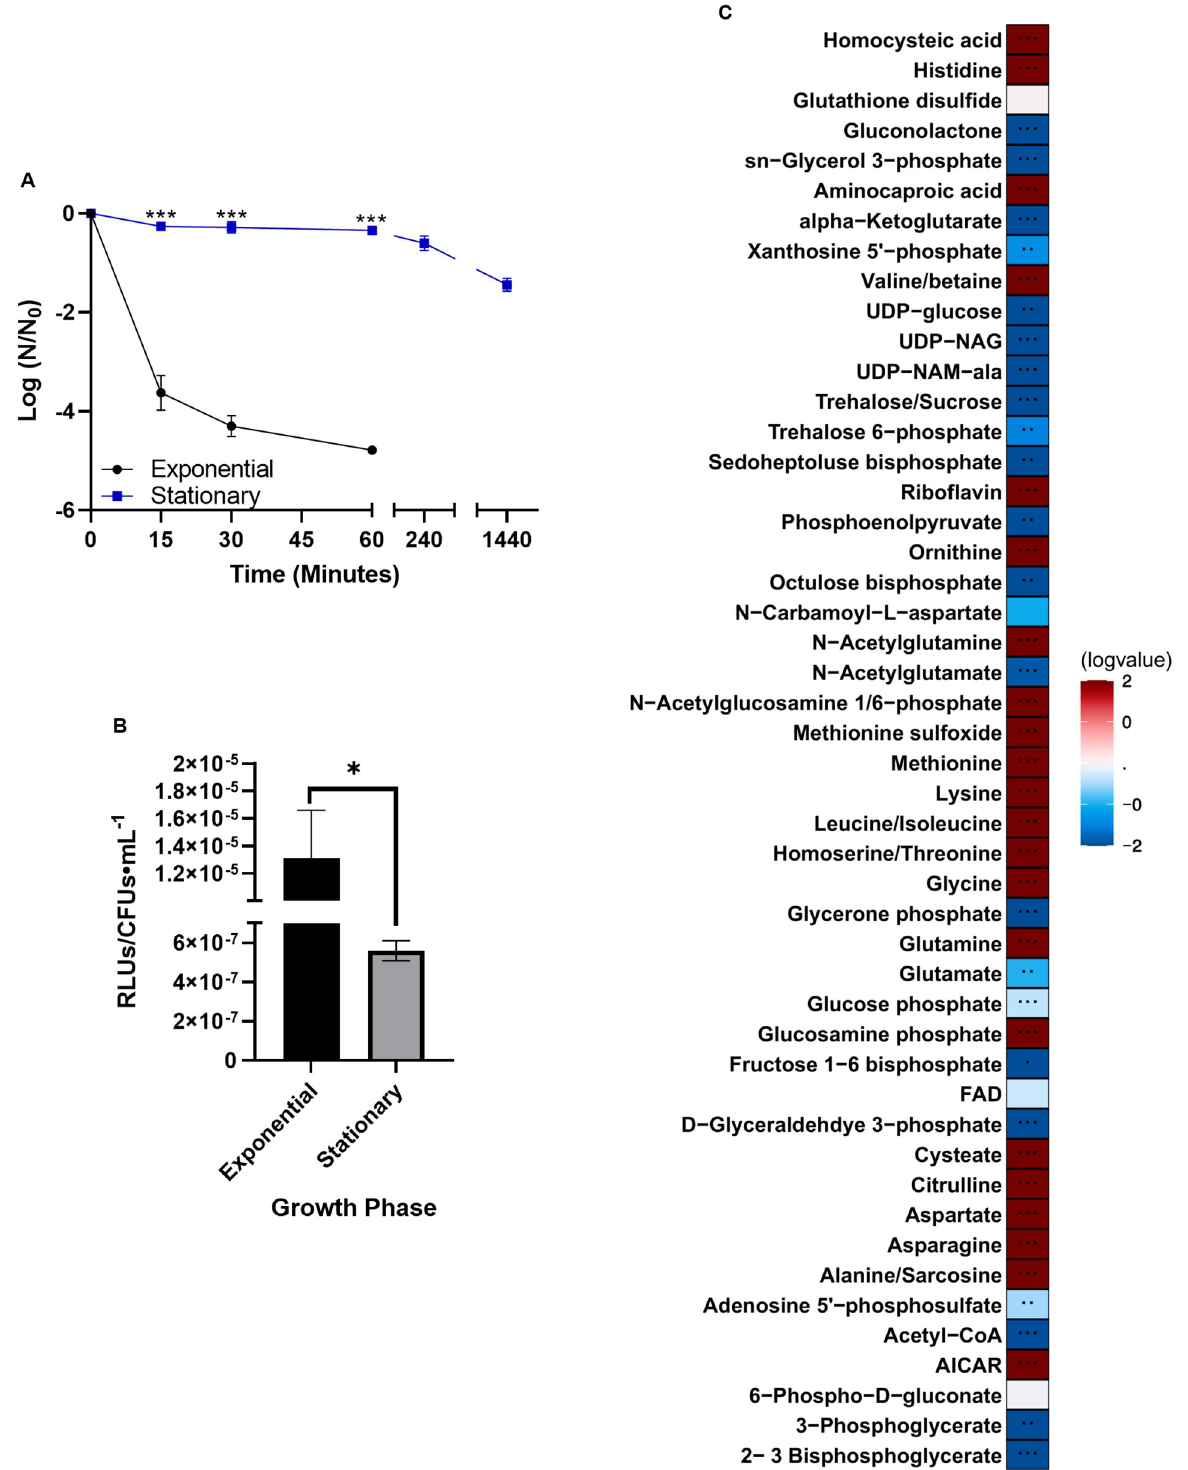
Fig 1. Cells in stationary phase show increased daptomycin tolerance and an altered metabolic profile. (A) Cells were treated with 30 μ g/mL daptomycin as described in Materials and Methods. Shown are the average log ratios of colony forming units ± standard deviations for n = 3 replicates. ��� P < 0.001. Note, cell survival for exponential phase cultures was below the limits of detection at 4 hours and beyond. (B) ATP levels of cells were measured using the Promega BacTiterGlo kit. Shown are the average relative light units (RLUs) normalized to colony forming